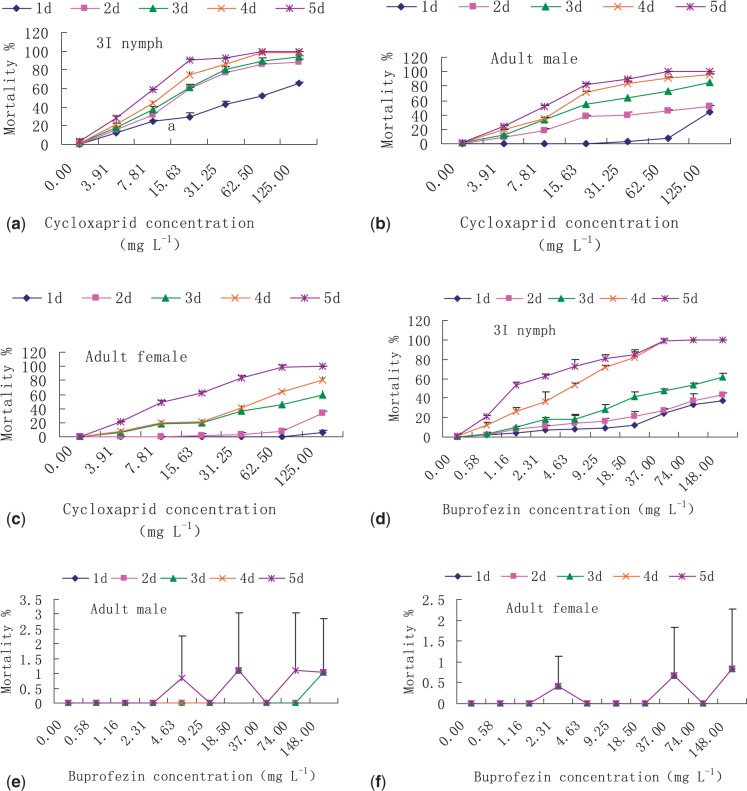
The effects of cycloxaprid and buprofezin on survival of WBPH nymphs and adults. (a) Cycloxaprid, third-instar (3I) WBPH nymphs. (b) Cycloxaprid, adult males. (c) Cycloxaprid, adult females. (d) Buprofezin, 3I WBPH nymphs. (e) Buprofezin, adult males. (f) Buprofezin, adult females. Values are means ± SD (n = 3).